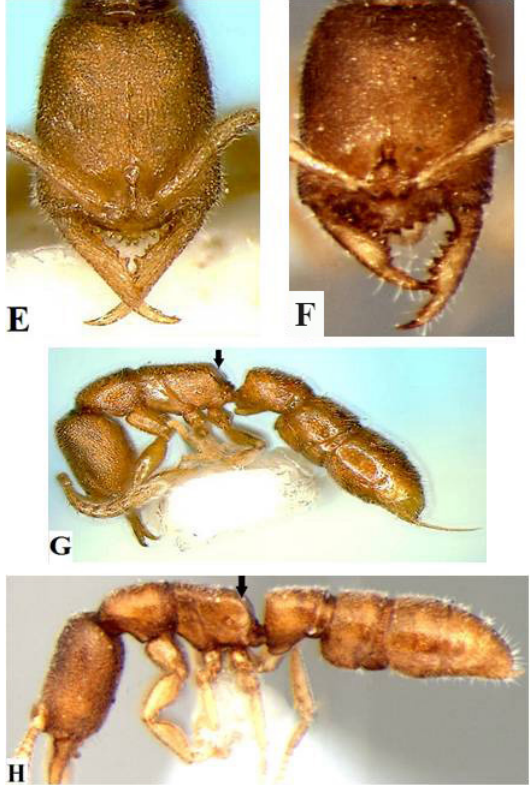
Figs E & G. S. sakaii (Terayama, 1989): E. Head in full-face view; G. Body in profile view. Figs F & H . S. xui sp. n.: F. Head in full- face view; H. Body in profile